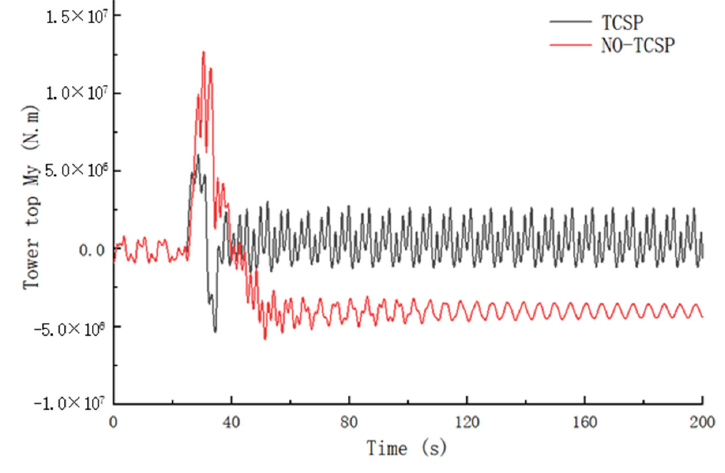
Figure 7. Tower top My comparison.